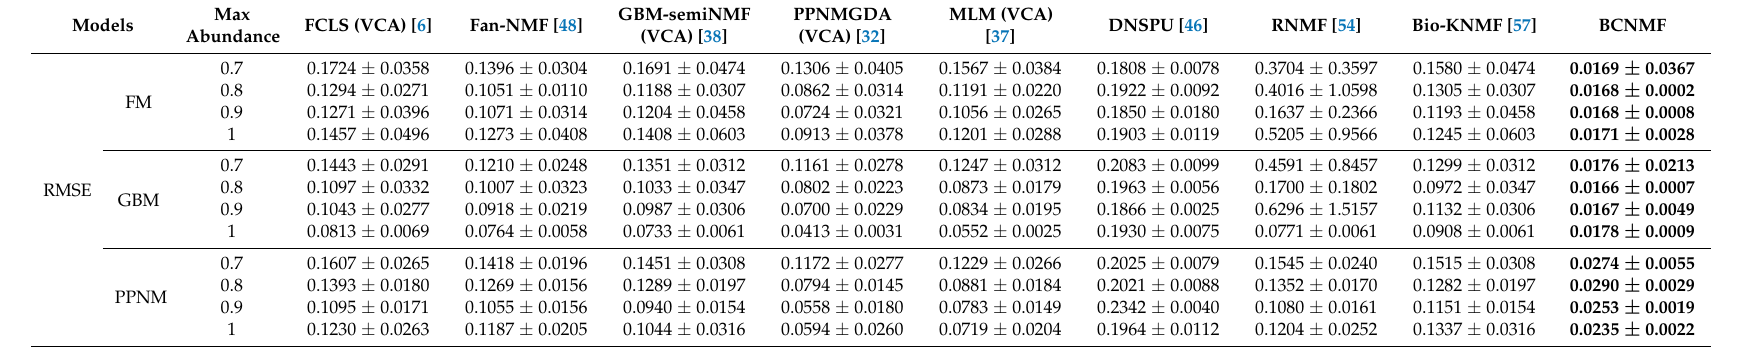
Table 9. RMSEs of all algorithms with different degrees of